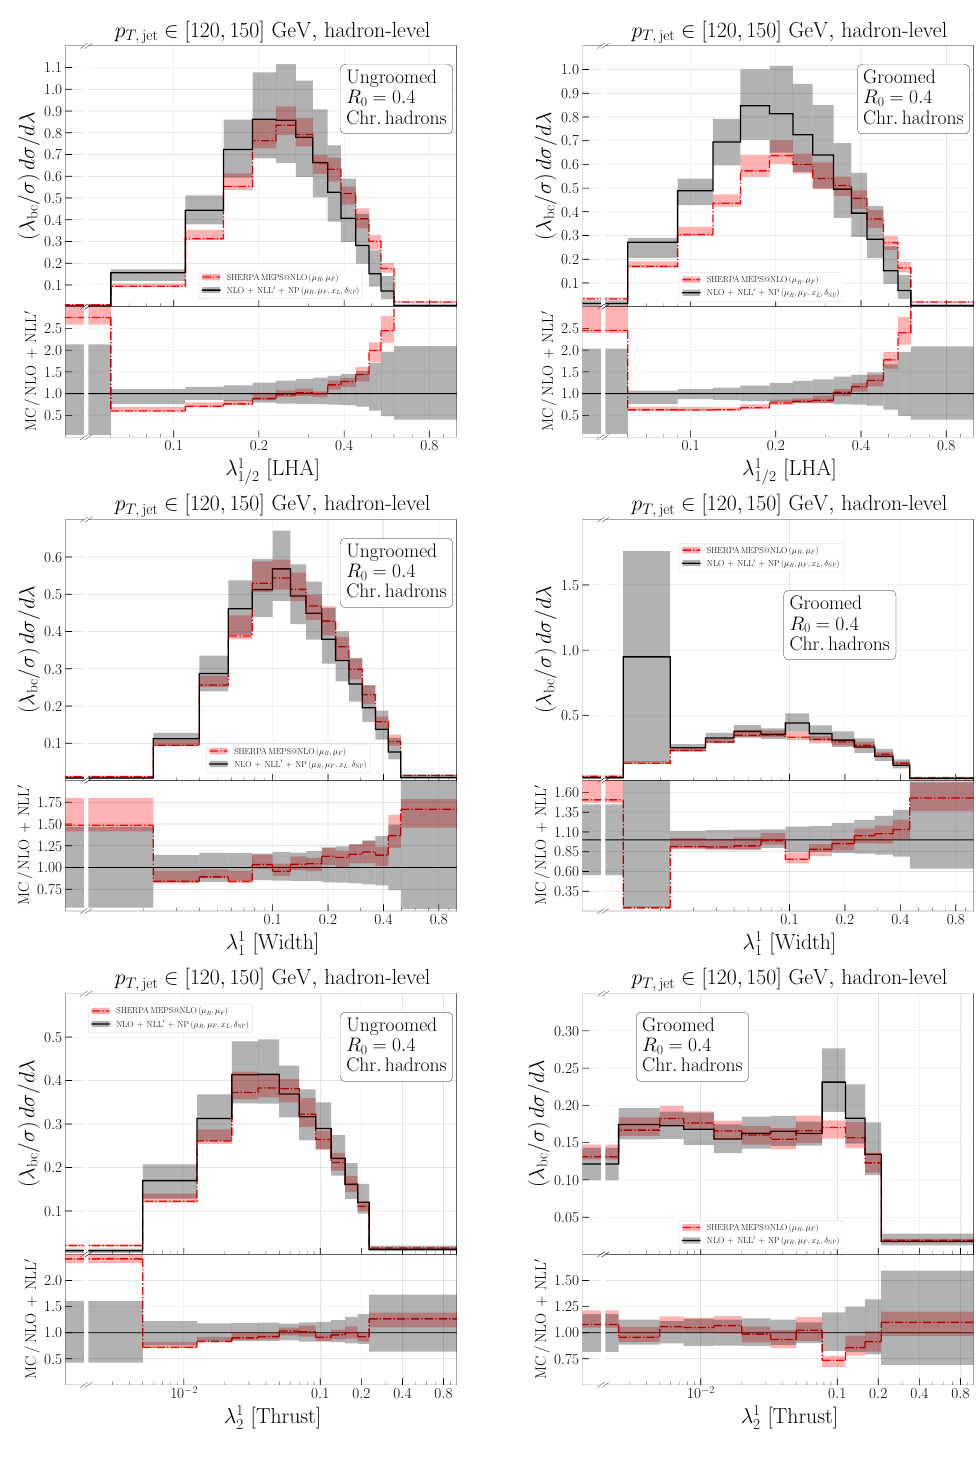
Figure 20 . Same as figure 16 but for R 0 = 0 . 4